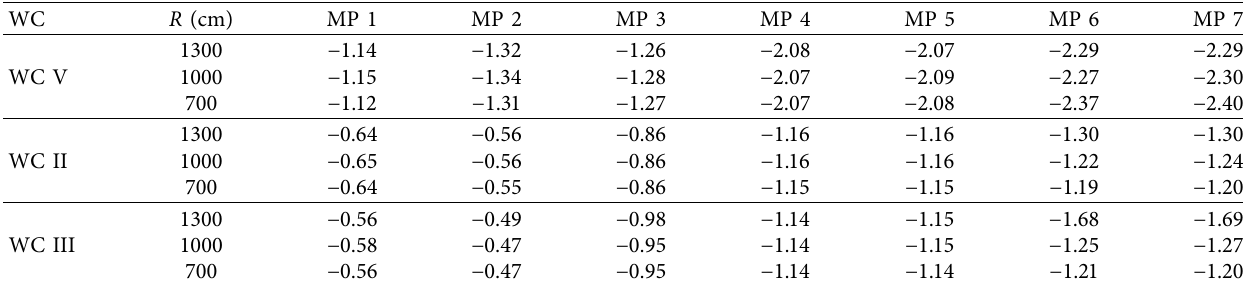
Figure 17: Deformation of the double-layer steel arch with variable stiffness. (a) The VCS under different radii of the invert. (b) The PCC under different radii of the Table 3: Stress results (unit: MPa).